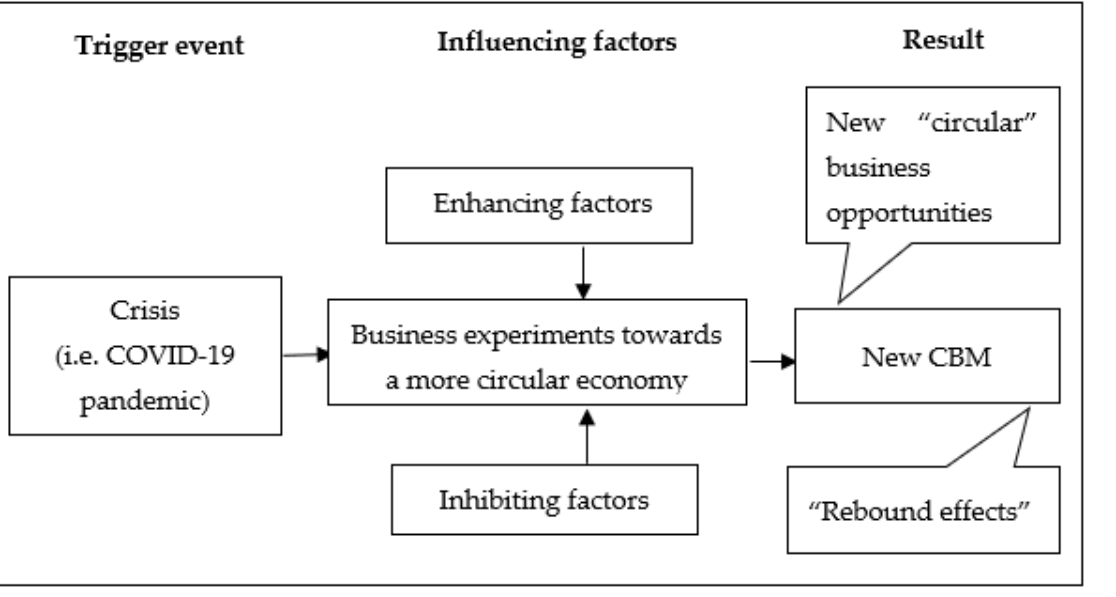
Figure 2. Crisis — New CBM relationship model in the context of influencing factors. Source: own Figure 2. Crisis—New CBM relationship model in the context of influencing factors. Source: elaboration. own